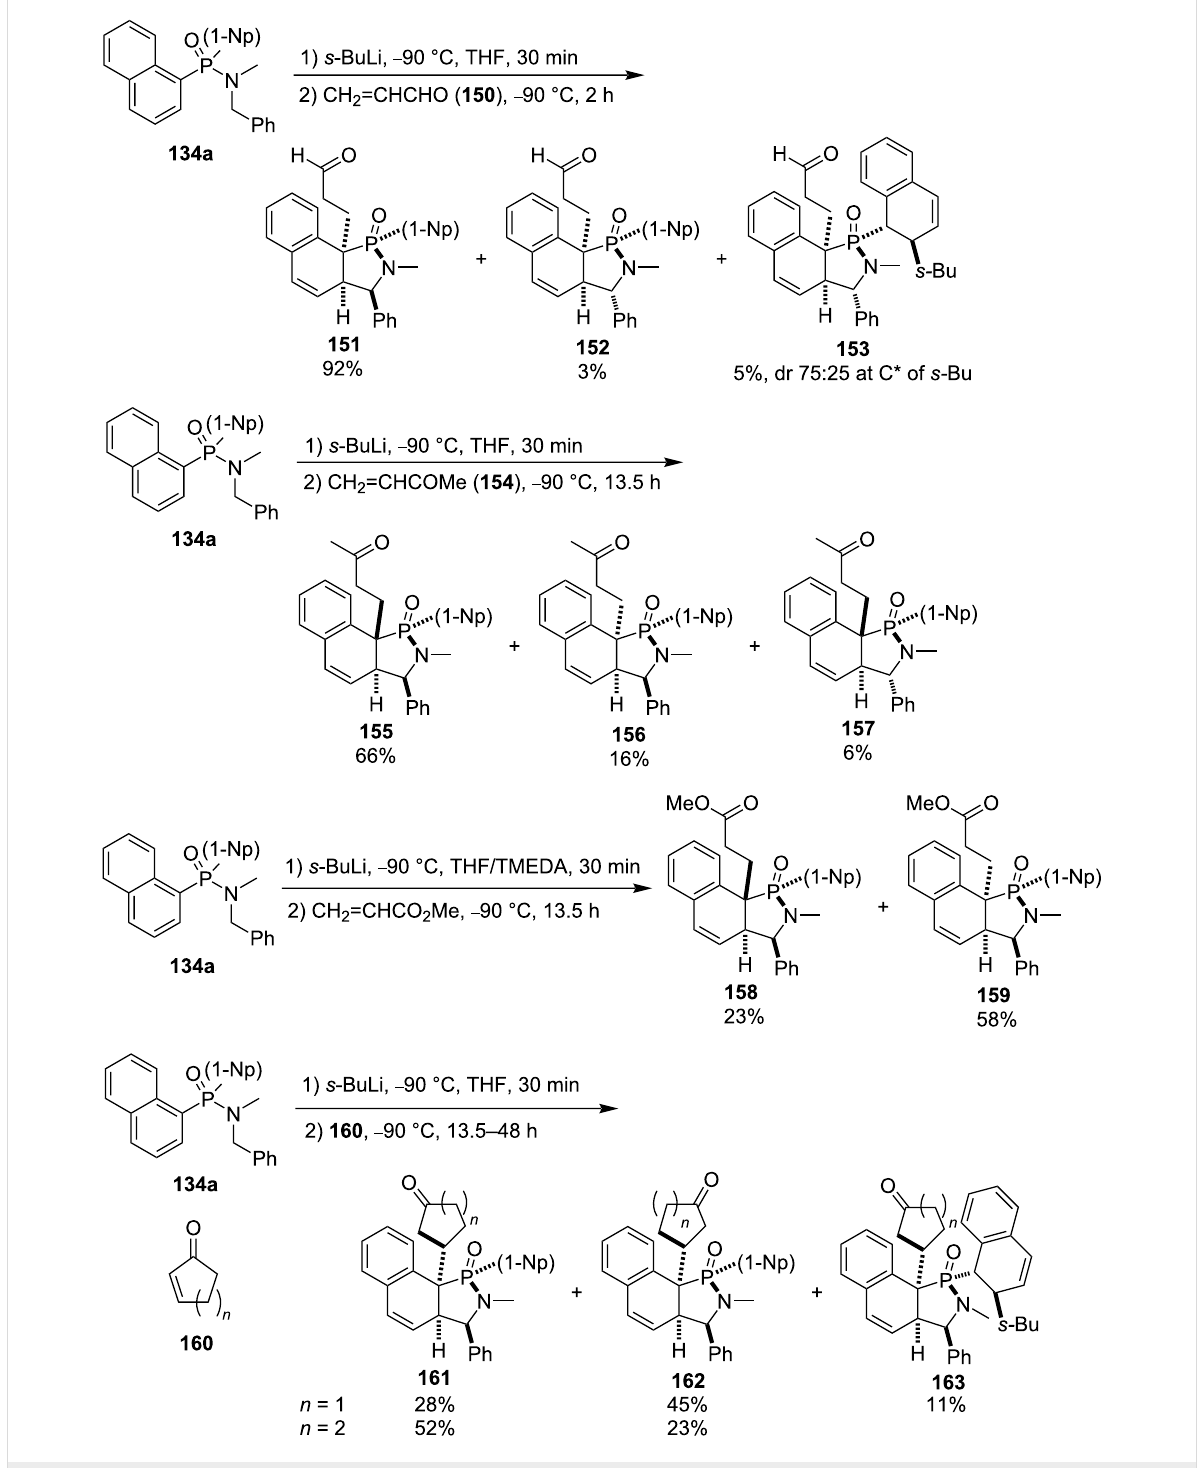
Scheme 26: Synthesis of carbonyl-containing benzocyclohexadiene-fused γ -phosphinolactams from dinaphth-1-yl- N -benzyl- N -methylphosphinamide.